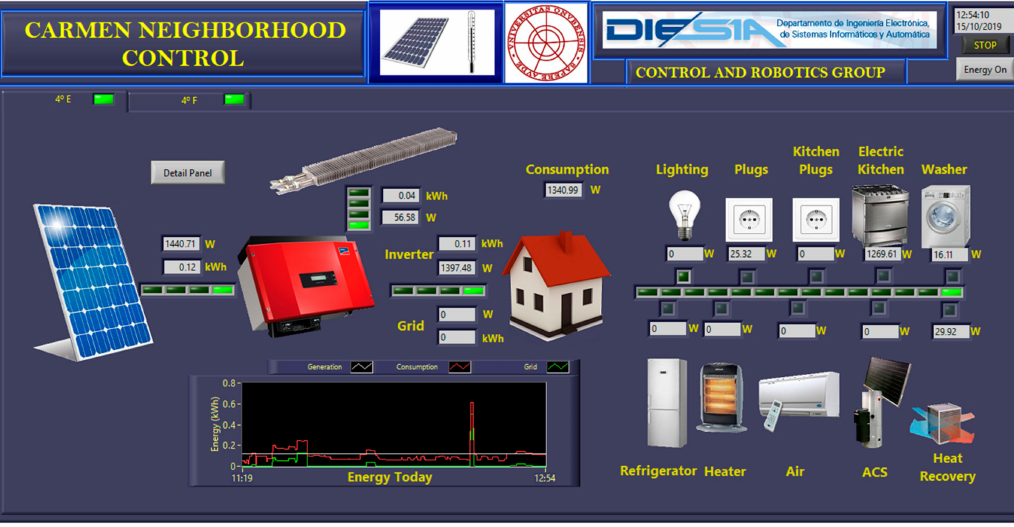
Figure 18. HAS screen. Left: Photovoltaic facility and its production. Right: Electrical circuits of the